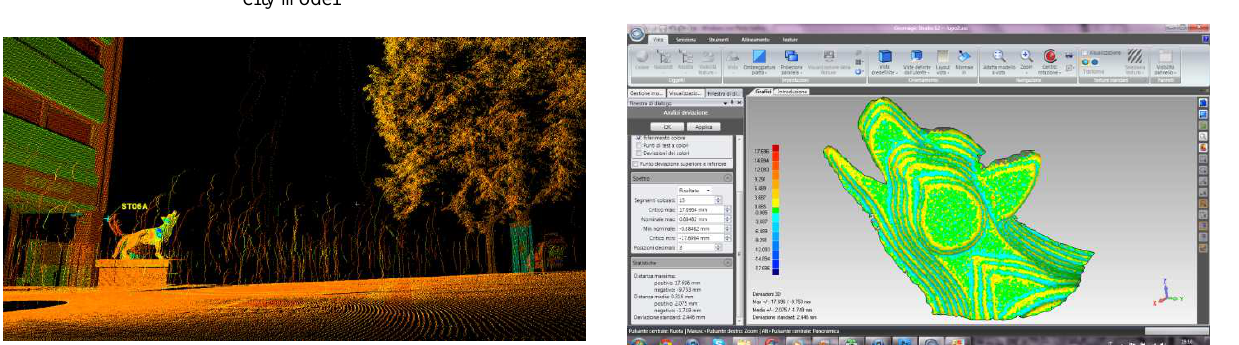
Figure 15. The point cloud of the Wolf of Sila and the surrounding zone, obtained with a scan of T.O.F. laser scanner